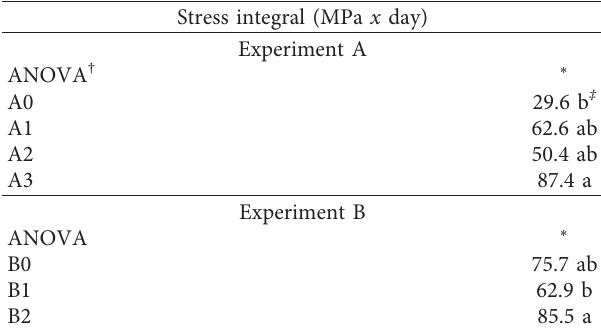
Table 1: Watering technique conditions of “Manzanilla” table olives of experiment A and experiment